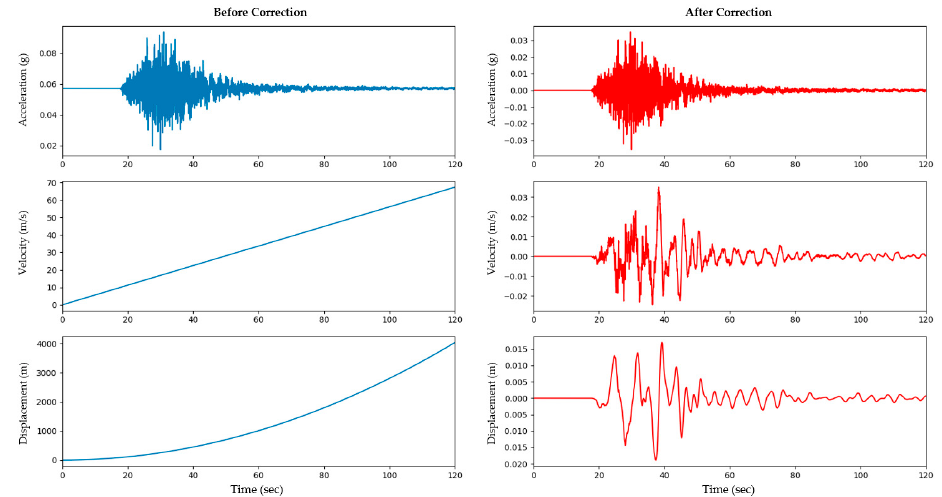
Figure 3. Earthquake data before and after correction (MYGH04).